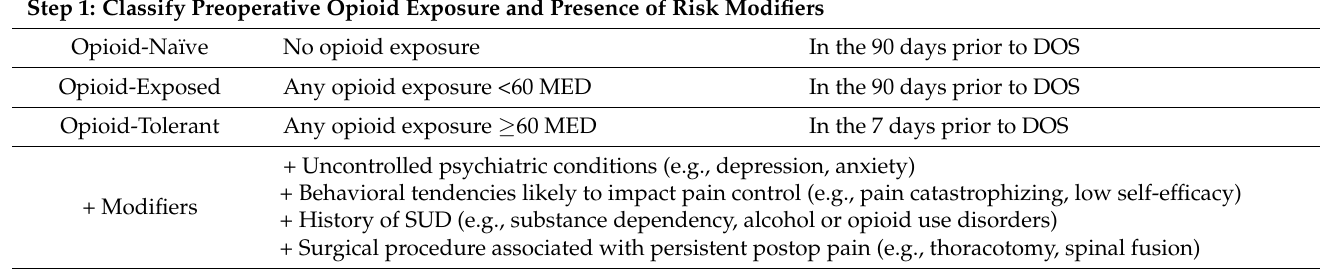
Table 2. O-NET+ Classification System and Recommended Optimization for Patients on Preoperative